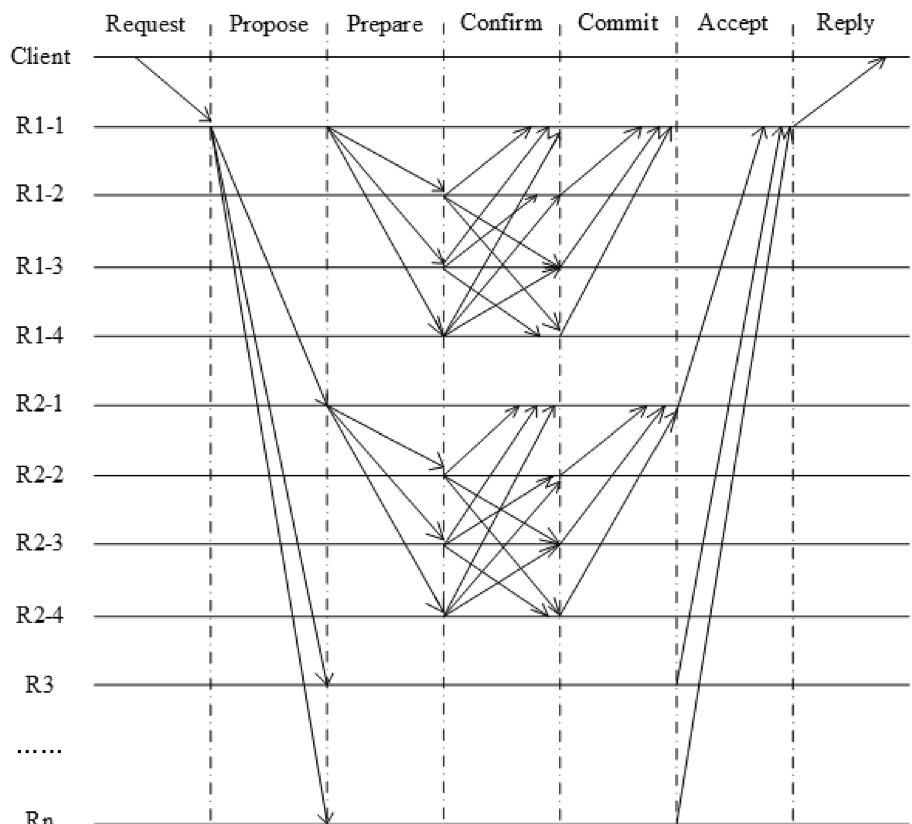
Figure 2. GPBFT algorithm flow